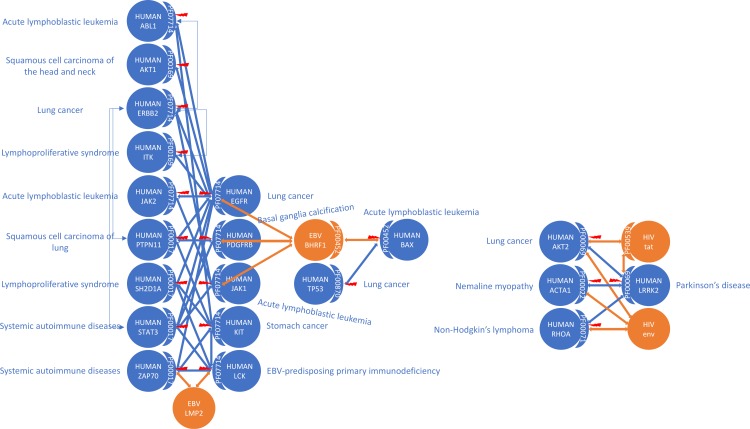
Viral proteins and VID mutations convergently perturb dense regions of the human domain interactome.Examples are given for EBV (left) and HIV (right).